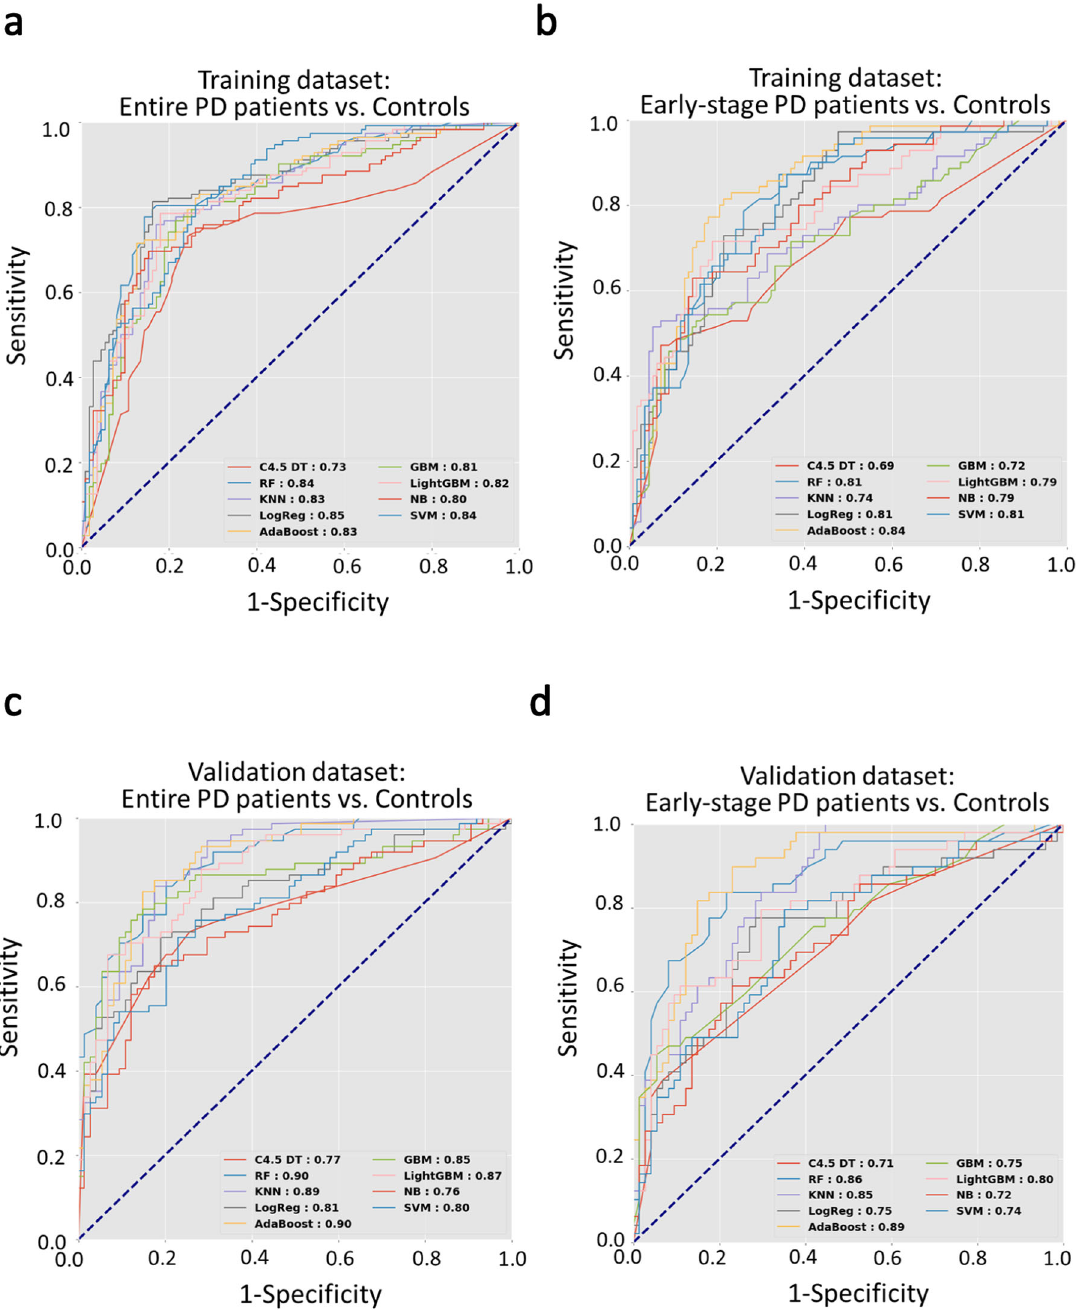
Fig. 2 Receiver operating characteristic curves calculated with nine deep-learning classi fi er models, based on combined facial and voice biometric features. The models were tested for their ability to differentiate between a all patients with PD during the “ on ” phase and controls, and b patients with early-stage PD during the “ on ” phase and age-matched controls, in the training dataset. The models were con fi rmed with an independent validation dataset, where they differentiated between c all patients with PD during the “ off ” phase and controls, and d patients with early-stage PD during the “ off ” phase and age-matched